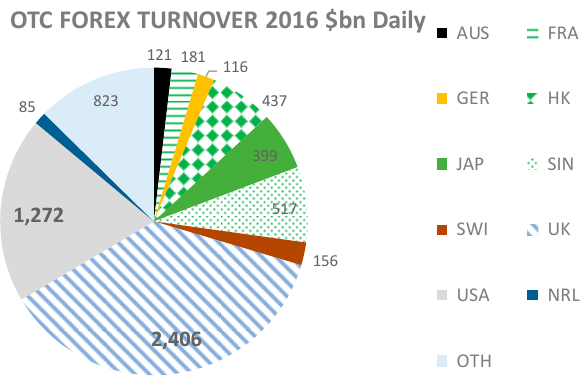
Figure 7. Over the Counter Foreign Exchange Turnover by Region, 2016. Source: Bank for International Settlements.